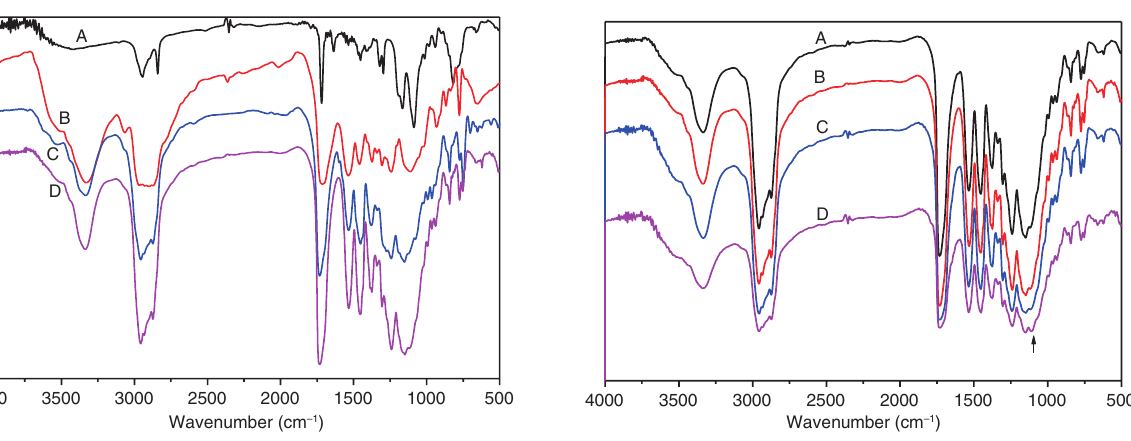
Figure 6: FTIR spectra of KH-570 (A), PU (B), SPUA00 (C), and SPUA0 (D).